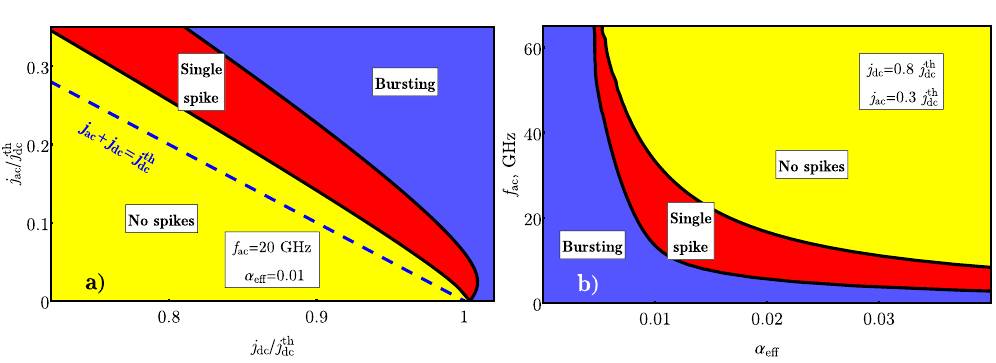
Figure 3. “Phase diagrams” of the spike generation regimes for different values of the experimentally controllable parameters of the driving current j dc , j ac , f ac and the AFM material dissipation α eff : ( a ) “Phase dcth vs. j j / dcth at the fixed value of the driving ac frequency f = 20 GHz and α = 0.01; ( b ) diagram” on the plane j j / ac eff ac dc th and = . j j / 0 3 “Phase diagram” on the plane f ac vs. α eff at the fixed values of = . j j / 0 8 dc dc ac dc